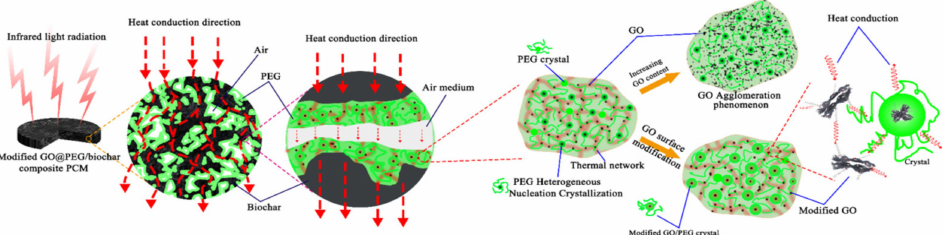
Figure 11. Schematic diagram of heat transfer mechanism in composite PCMs: thermally enhanced effect of GO particles, crystallization of PEG, photothermal conversion of